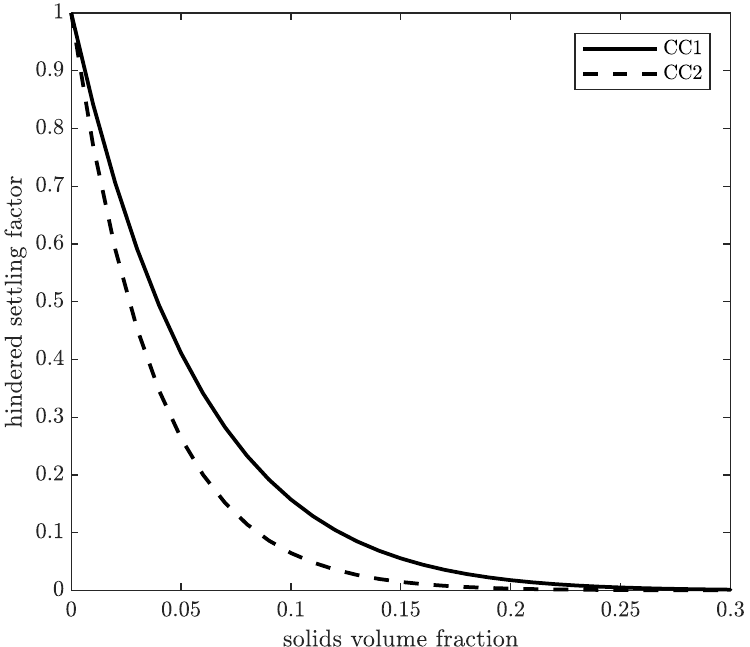
Figure 3. Hindered settling function as a function of the solids volume fraction for the two used calcium carbonate